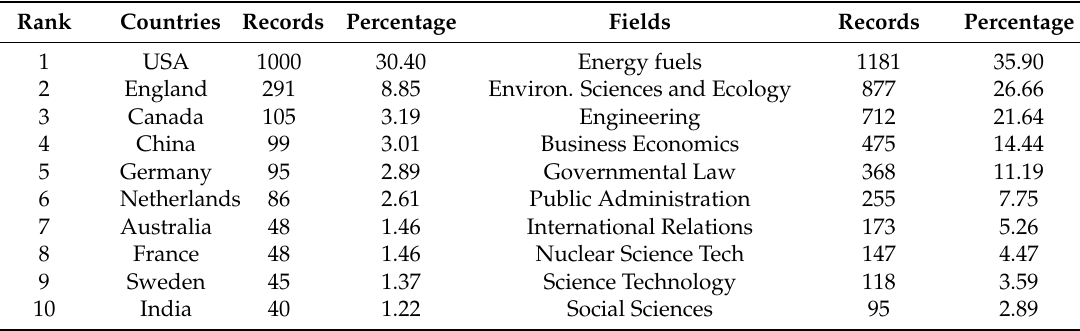
Figure 2. Time profile of energy policy literature (Source: ISI Web of Science). Table 1. Distribution of countries and research fields (Top 10). Source: ISI Web of Science.